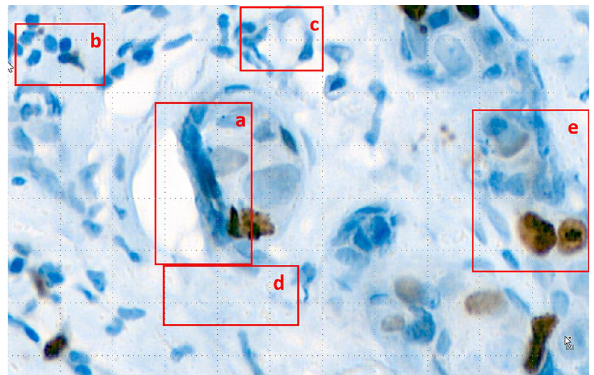
Figure 2. Example of IHC slide. In the red regions there are marked: ( a ) artifacts, ( b ) lymphocytes, ( c ) blood vessels, ( d ) collagen fibers and ( e ) tumour cells with high and low expression of Ki-67 protein (our assumed